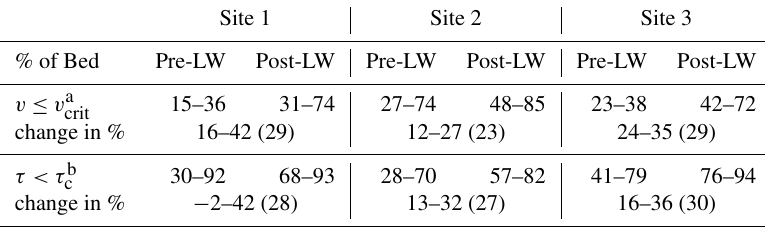
Table 4. Hydrograph modeling results for habitat metrics of velocity ( v < v a percentage of the channel bed pre- and post-LW; change in percentage available as fish habitat pre- and post-LW.